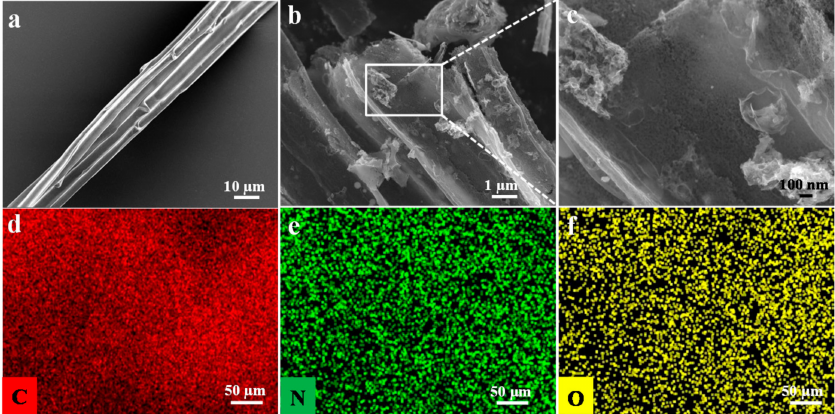
Figure 4. SEM images of C800 ( a ), CN800 ( b , c ), and the corresponding EDX mapping of ( d ) C, ( e ) N, ( f )